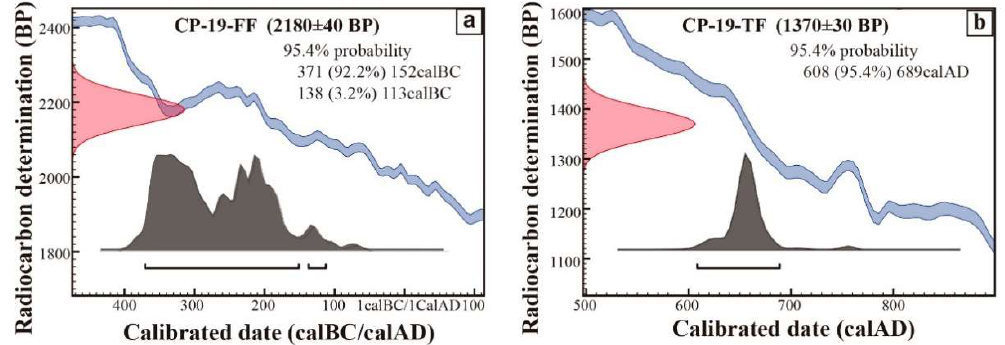
Figure 11. Calibrated 14 C dates of two fraction-sizes of the same lime mortar from Portilla Castle, ( a ) fine fraction (FF), and ( b ) target fraction (TF) obtained with OxCal v 4.1.7 [63] and IntCal09 atmospheric data [64]. Table 4. Results of AMS 14 C dates for different grain-size fractions of mortar binder. Lab Code